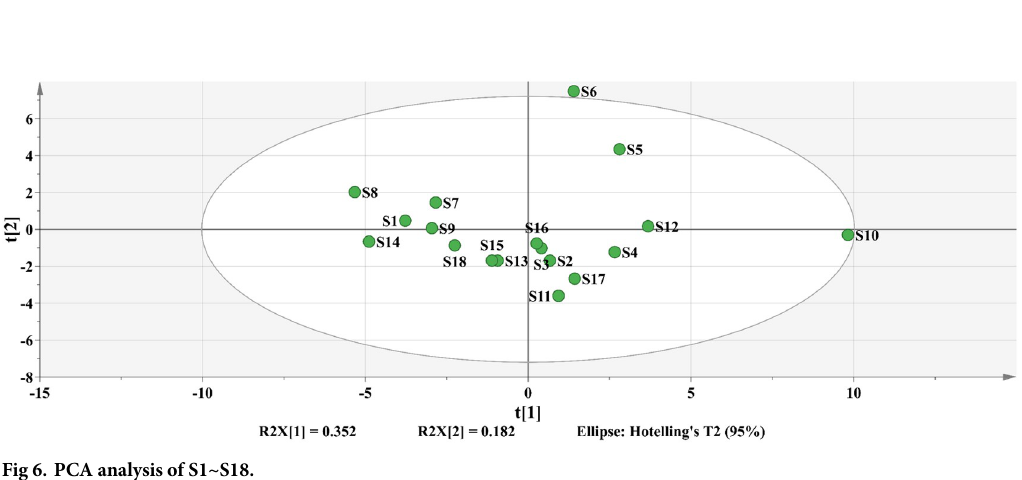
Fig 6. PCA analysis of S1~S18.